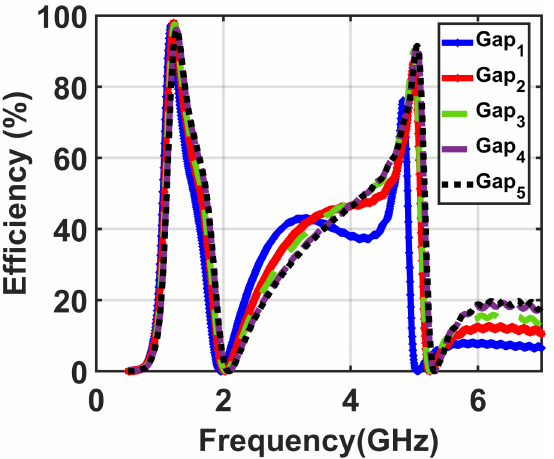
Figure 4. Obtained results of the efficiency of the five investigated cases for the values of the gap from Gap 1 = 0.2 mm to Gap 5 = 0.6 mm.